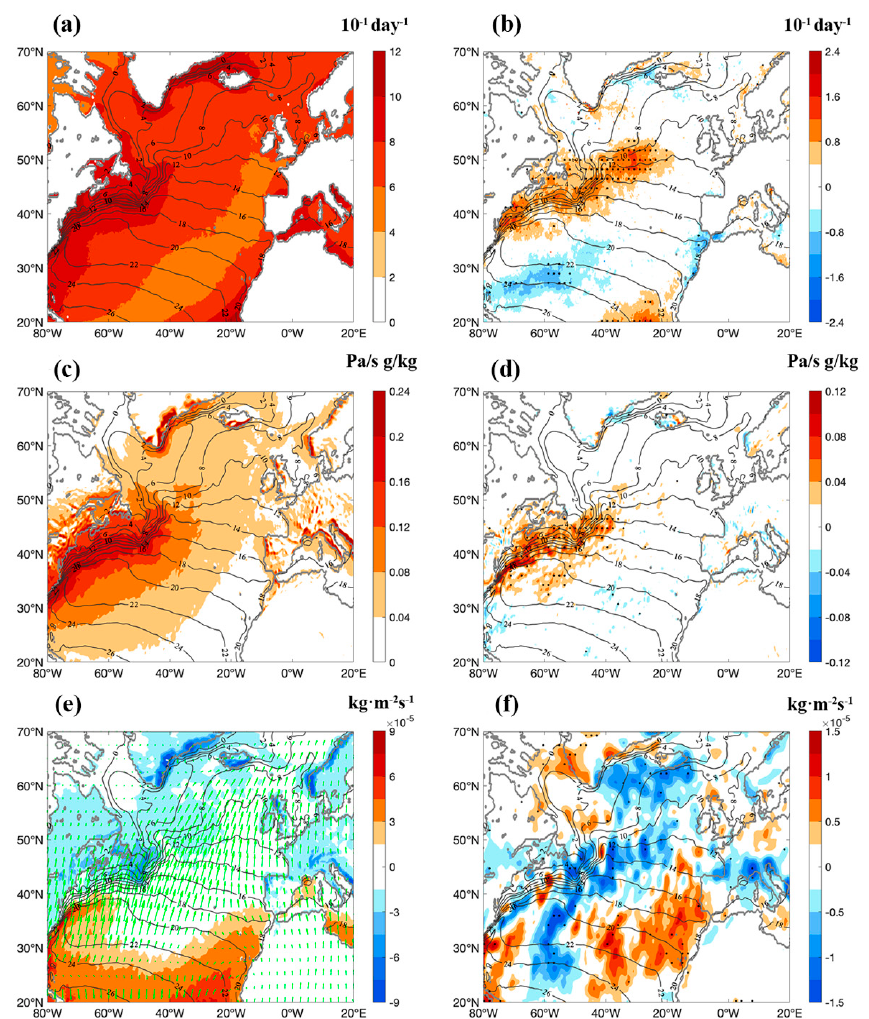
Figure 8. Left column is the temporal mean during 1997–2019 of ( a ) Eady growth rate at 850 hPa (10 − 1 day − 1 ), ( c ) upward water vapor flux < wQ > at 850 hPa (Pa / s g / kg), ( e ) mean vertically integrated moisture divergence (kg · m − 2 s − 1 ). The right column is for the same variables as the left but for their increase ( b , d , f ). Contours are mean SST between 1997 and 2019 ( ◦ C). Black dots mark the region in which the trend passed the 95% significance level. Arrow vectors in ( e ) are the mean vertical integrated water vapor flux (kg ⋅ m − 1 s − 1 ).